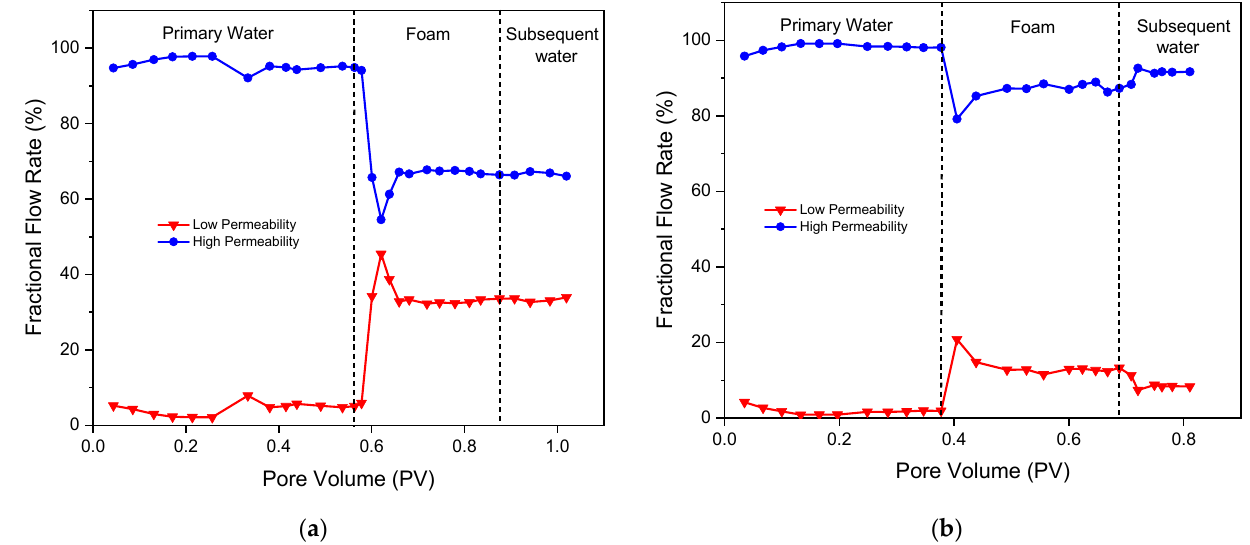
Figure 7. Influence of permeability ratio on fractional flow rates: ( a ) permeability ratio 5520/29; ( b ) permeability ratio 10,200/30.